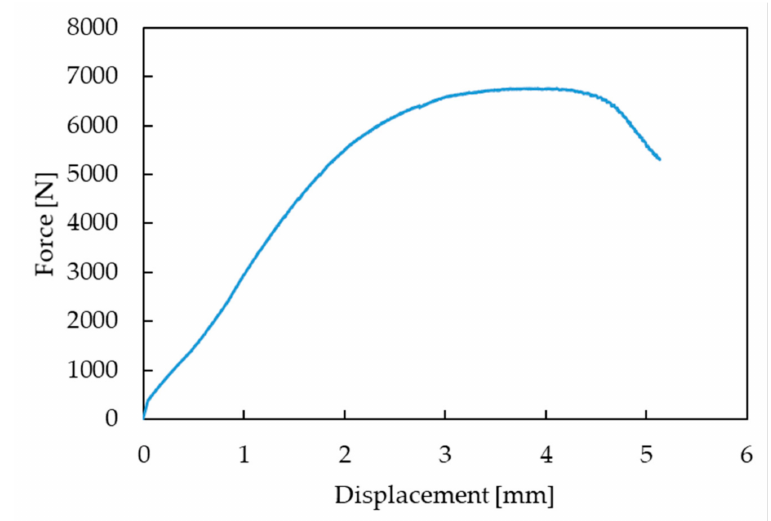
Figure 12. Static bending of the turbine blade at 950 ◦ C.